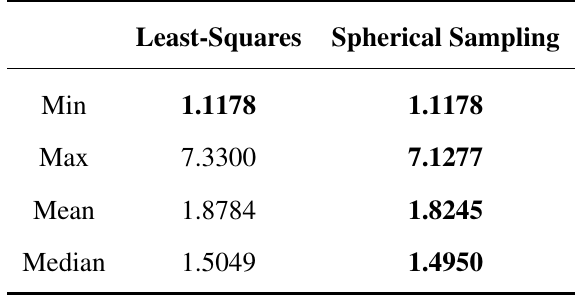
Table 2. ∆ E results: average for 37 cameras. 00